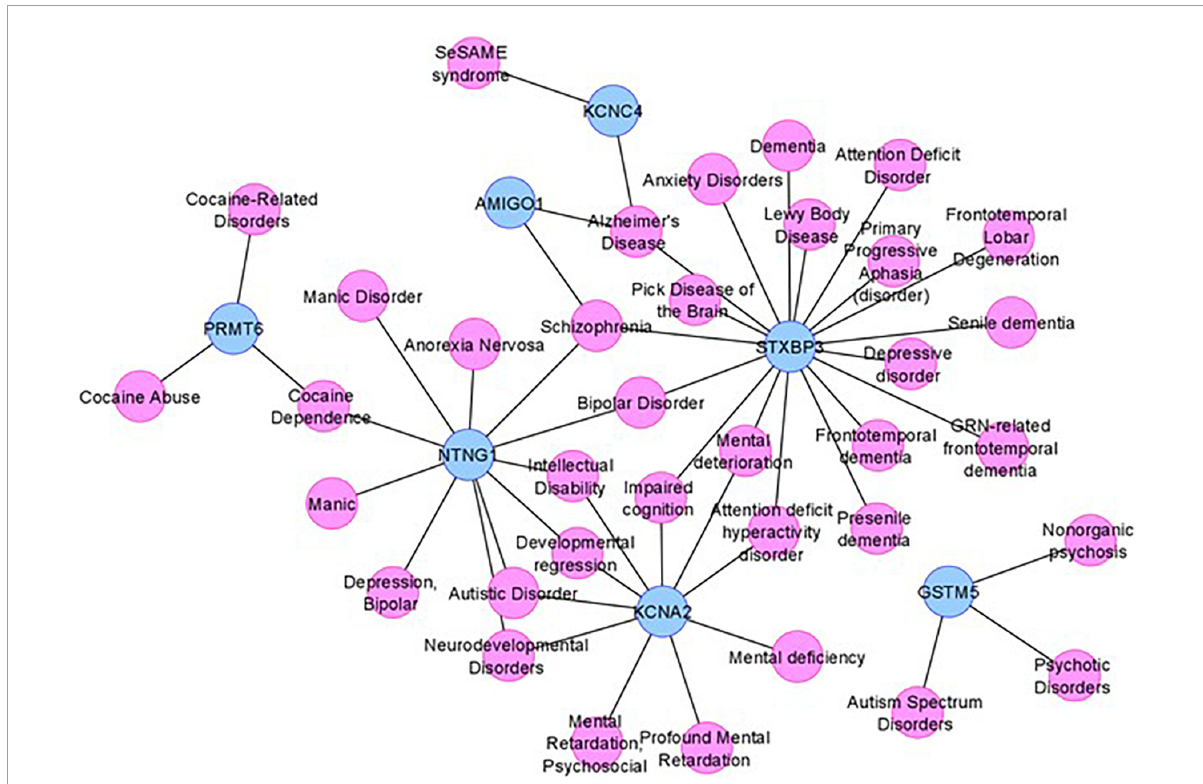
FIGURE4 The mental disorder network. The candidate genes are depicted by blue nodes, and the disease terms are depicted by pink nodes. Edges correspond to disease